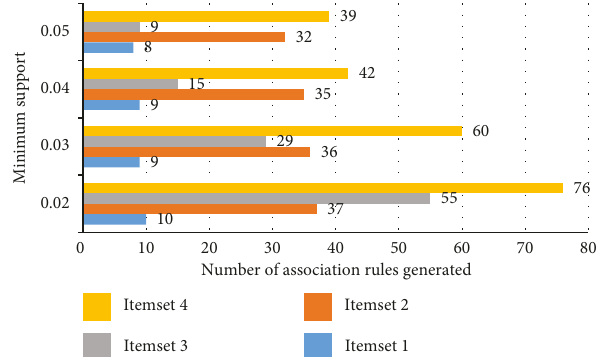
Figure 6: The trend of the number of fuzzy association rules with the number of itemsets.